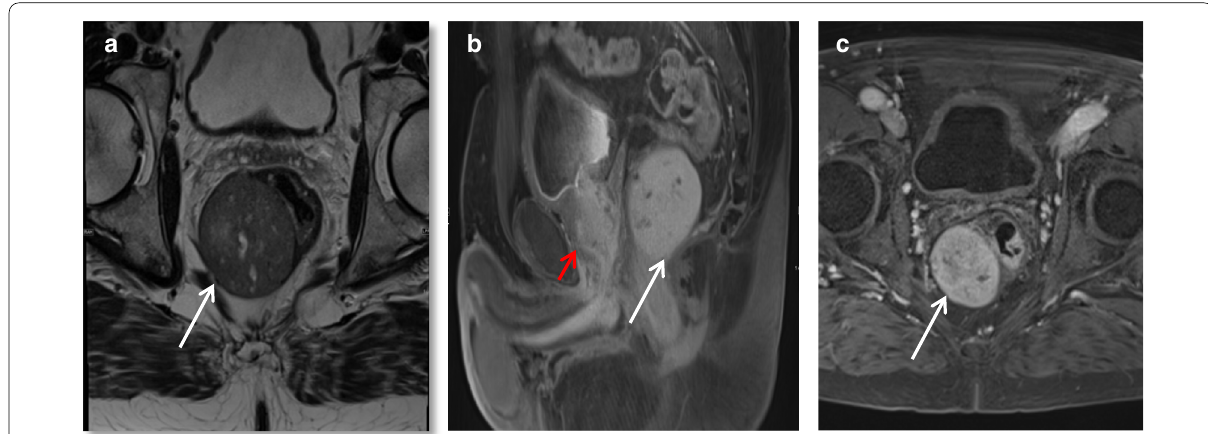
Fig. 22 GIST Well-circumscribed submucosal 5 cm heterogeneous mass (white arrow) arising from the right posterolateral wall of the lower rectum is ( a ) predominantly T2 hyperintense relative to rectal wall with ( b ) and ( c ) sagittal and axial T1 fat saturation post-contrast sequences showing vivid contrast enhancement. The mass is seen posterior to the prostate in B (red arrow). Biopsy confirmed spindle-type histologically low-grade GIST